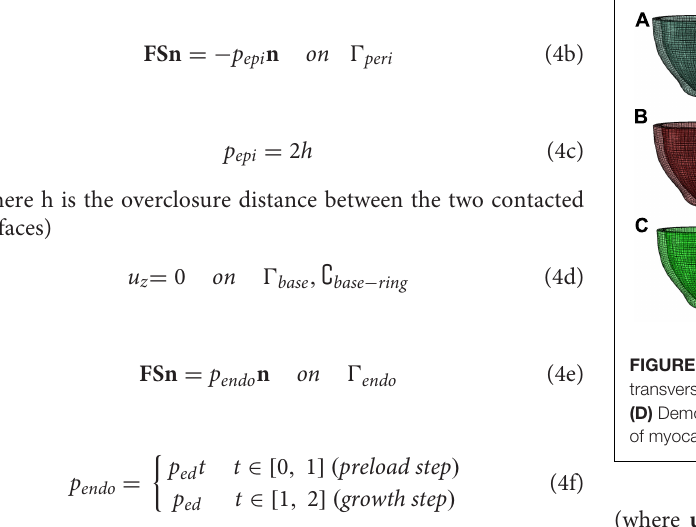
and i + 1 refer to 2 2